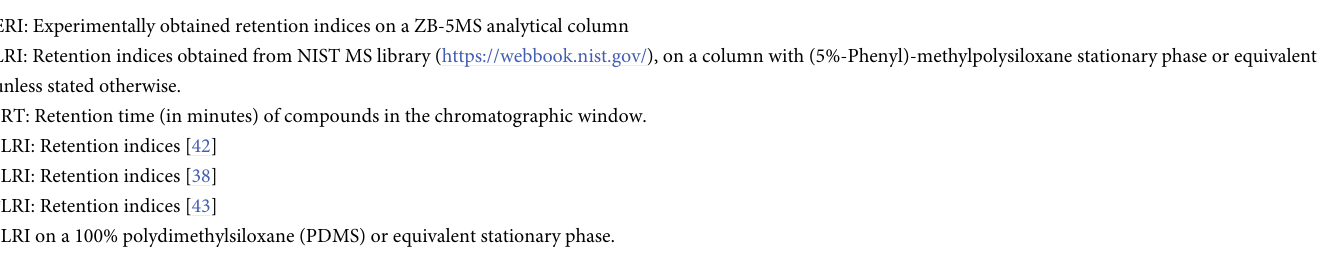
nitrogen and/or sulphur containing compounds (4 compounds). Parasitism status signifi- cantly affected caterpillar odours (PERMANOVA: F = 4.594, p = 0.011), from which the 1,53 top four VOCs in VIP-score (3-octanone, ( Z )-3-hepten-1-ol, 3-methyl-3-buten-1-ol and 3-octanol) and 3-pentanone were characteristic for parasitised caterpillars (Table 1 highlighted in yellow and Fig 2A,). A compound was considered characteristic for parasitised caterpillars when it was significantly increased for parasitised caterpillars in at least one pairwise compari- son with unparasitised caterpillars undergoing the same treatment (e.g. Cg-ST and Pb-ST). The included treatments allowed us to address the origin of these compounds. Starvation (ST) and starvation followed by external microbiome disruption (ST+EMD) significantly affected caterpillar body odours (PERMANOVA: F = 17.292, p < 0.001), but differences 2,53 between parasitised and unparasitised caterpillars were still present. Pairwise analyses within starved treatments (Pb-ST vs Cg-ST) and starved then external microbiome disrupted caterpil- lars with different parasitism statuses (Pb-ST+EMD vs Cg-ST+EMD) highlight the importance of 3-octanone, ( Z )-3-hepten-1-ol, 3-methyl-3-buten-1-ol, 3-octanol and 3-pentanone in char- acterising parasitism status of caterpillars (S1 and S2 Figs and Table A in S1 Supporting Infor- mation). This indicates that the source of these VOCs was elsewhere than the frass and skin of the caterpillar, and that they are likely formed internally in the caterpillar. Overall, starvation followed by external microbiome disruption (ST+EMD) did not impact caterpillar odours strongly, compared to only starvation (ST). Only 3-methyl-3-buten-1-ol was found to be significantly reduced when comparing starved and starved then external micro- biome disrupted treatments of the same parasitism status. Accordingly, the separation in OPLS-DA was less evident between starved and starved then external microbiome disrupted caterpillars with the same parasitism status (Figs 3A, S3 and S4). Untreated caterpillars pro- duced several compounds at a higher level (Figs 2B and 3B), including most nitrogen- and/or sulphur-containing compounds. This is likely due to the presence of frass during the head- space collection of untreated caterpillars. Whether hyperparasitoid attraction to caterpillar odours could be explained by frass was investigated in a two-chamber olfactometer setup